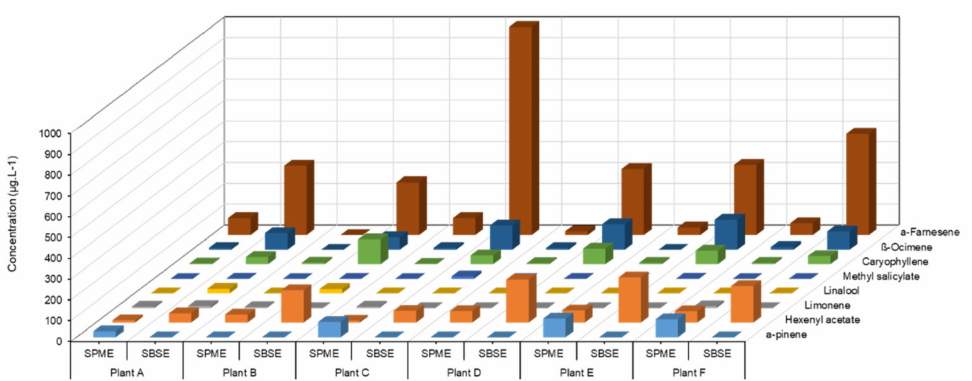
Figure 1. Comparison of VOC signal responses from elicitor-treated grapevine leaves, detected by SPME fibre and SBSE stir bar in bag containment. Amounts ( µ g/L) of eight targeted VOCs collected for 4 h on D3 after sulphated laminarin (PS3, 2.5 g/L) treatment of four plants (A to D) individually placed in a bag, using SPME fibres and SBSE stir bars (Twisters TM ) as